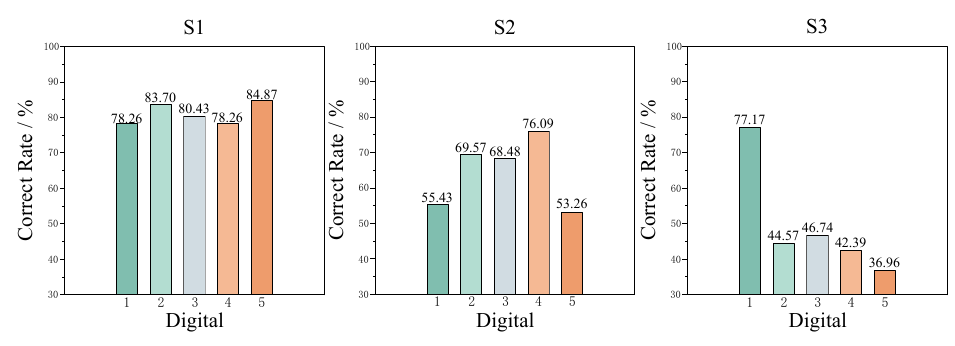
Figure 6. S1–S3 cognitive correctness.